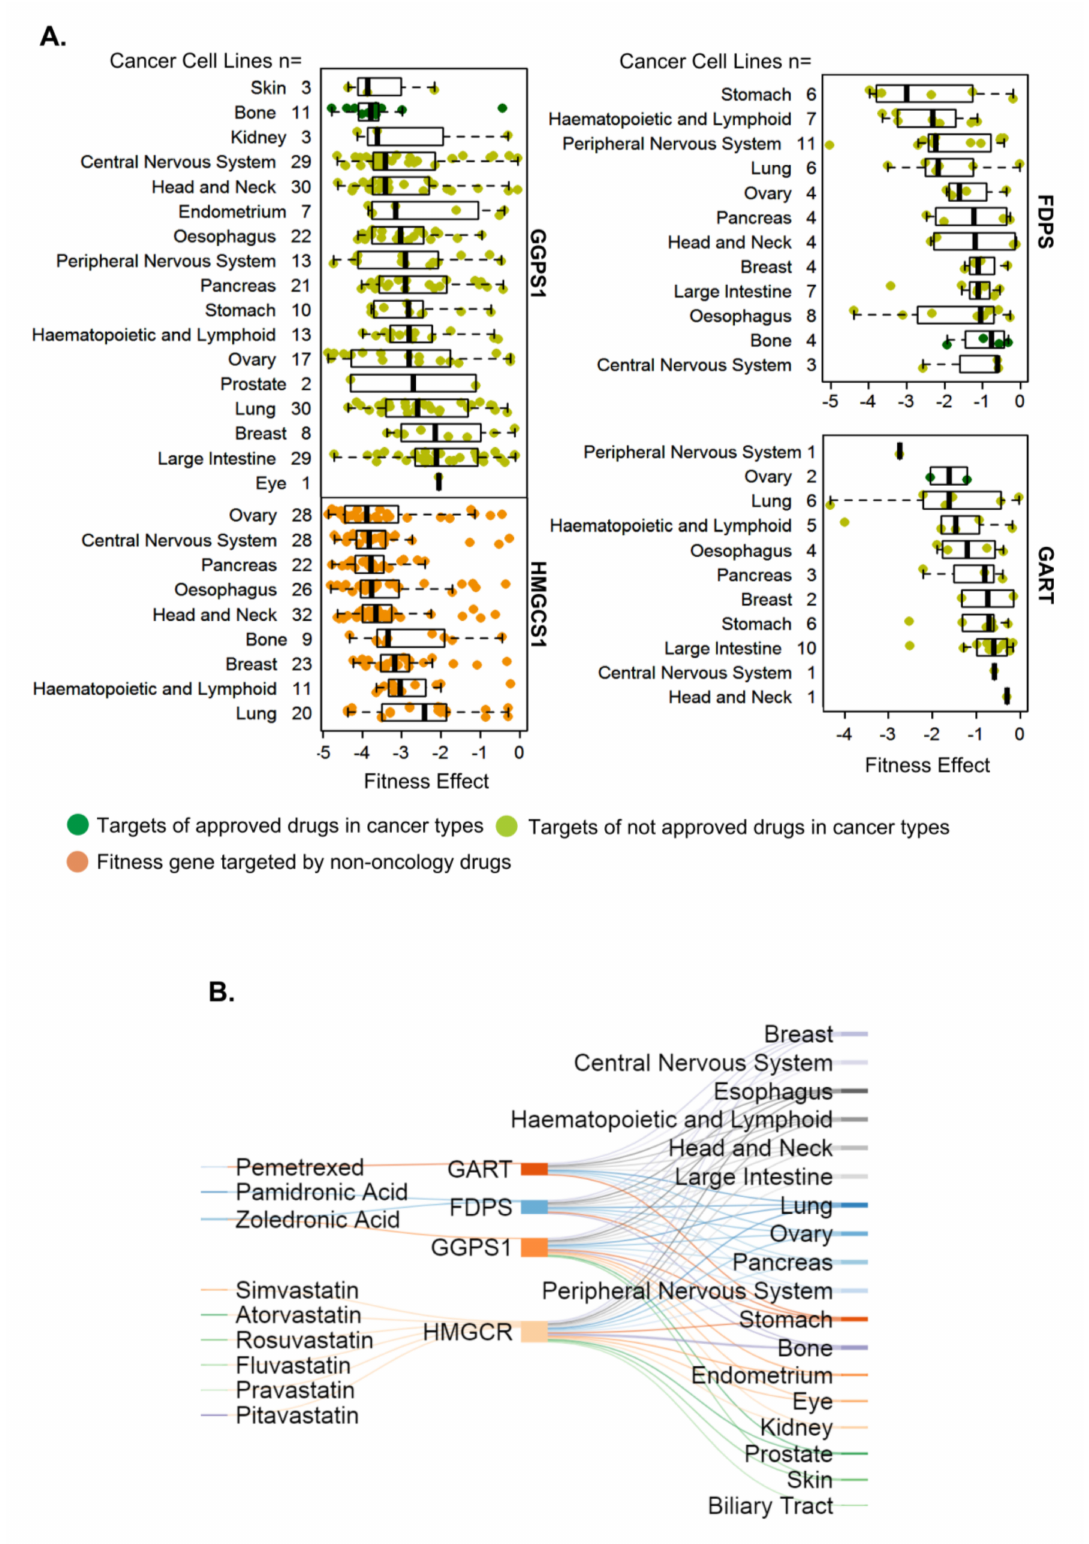
Figure 6. Fitness dependency of the four enzymes of the mevalonate/cholesterol pathway in cancer-types. ( A ). Status of cellular fitness of cancer types upon knocking out GGPS1, FDPS, HMGCS1, or GART in cancer types for which drugs utilizing these molecules are approved (dark green dots) or not approved (light green) or are non-oncology drugs (orange). ( B ) Relationship between the four cellular targets or effectors and fitness dependency of cancer types, for which indicated drugs targeting these molecules are not